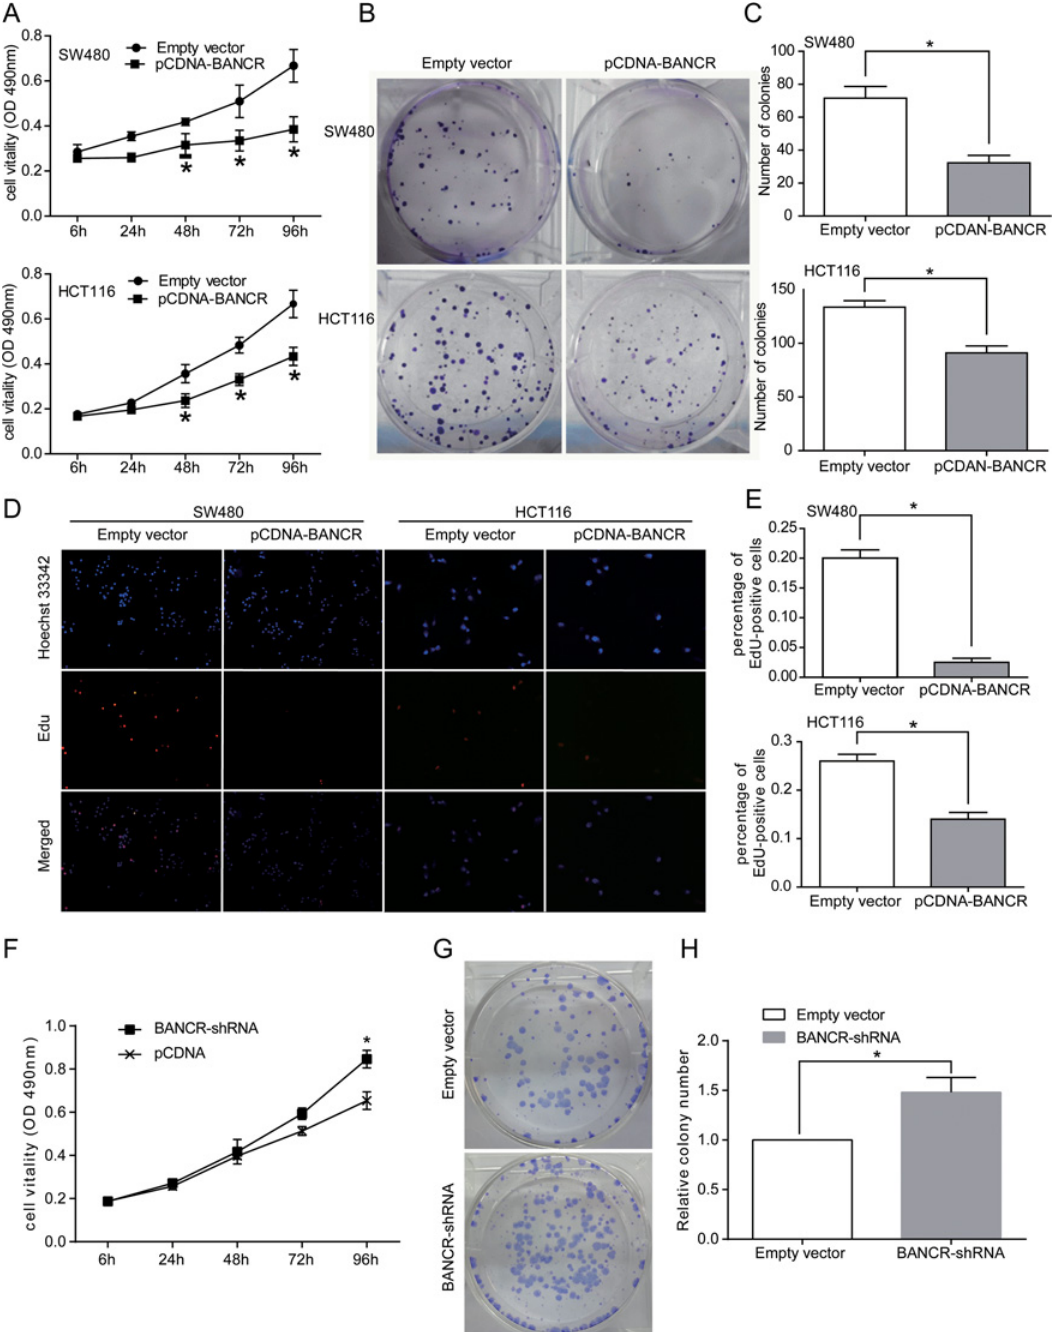
Fig 2. Effects of BANCR on colorectal cancer cell proliferation in vitro. (A) MTT assay was performed to determine the proliferation of SW480 and HCT116 cells. Data represent the mean ± S.D. from three independent experiments. (B and C) Colony-forming growth assays were performed to determine the proliferation of SW480 and HCT116 cells. The colonies were counted and captured. (D and E) Proliferating SW480 and HCT116 cells were labeled with EdU. The Click-it reaction revealed EdU staining (red). Cell nuclei were stained with Hoechst 33342 (blue). The images are representative of the results obtained. (F) MTT assay was performed to determine the proliferation of HCT116 cells. Data represent the mean ± S.D. from three independent experiments. (G and H) Colony-forming growth assays were performed to determine the proliferation of HCT116 cells. The colonies were counted and captured. * ,P <